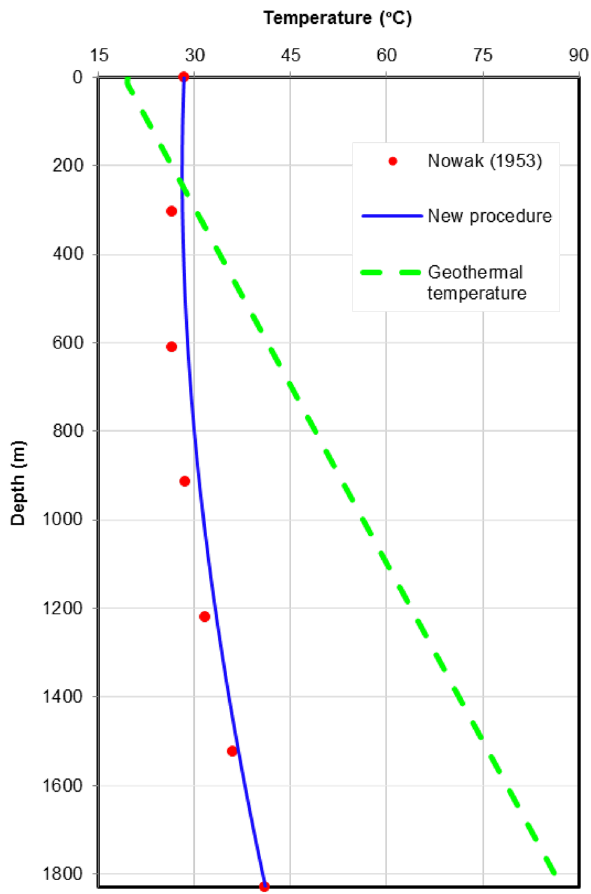
Fig. 4 Comparison of temperature distribution with well depth from Nowak (1953) and predicted by the new procedure